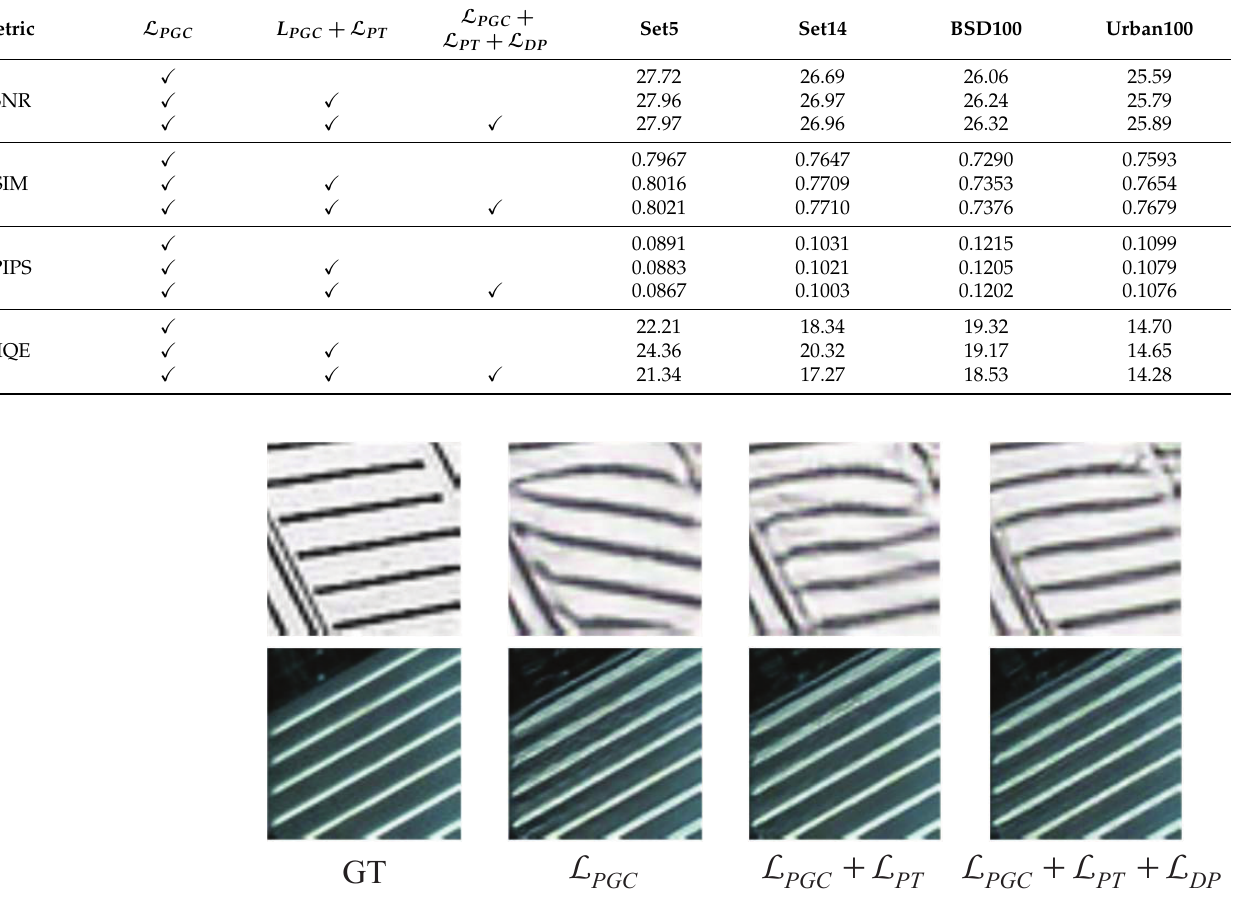
Figure 8. Visual evaluation of the proposed method under the ablation